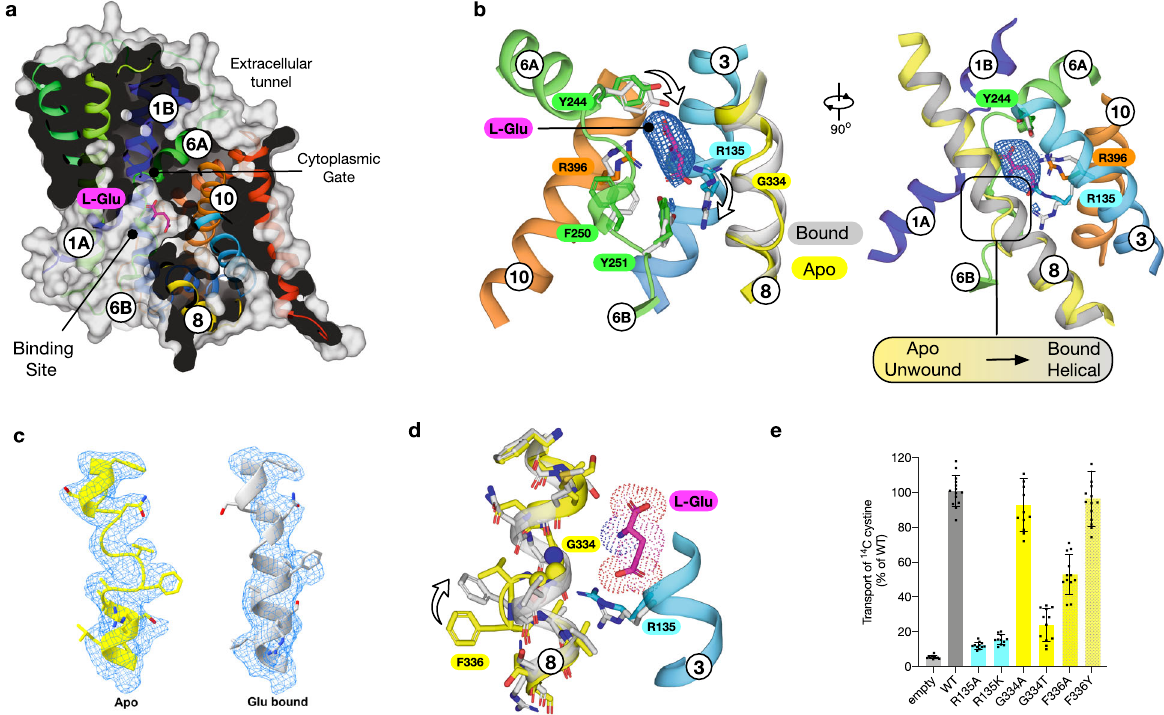
Fig. 3 L -glutamate bound structure of xCT. a Molecular surface representation of SLC7A11 showing the bound L-Glu ligand. b Zoomed in view of the ligand binding site with differences between TM8 in the apo (coloured) and bound (grey) states. The EM density for the ligand is shown, threshold 8 sigma. c Cryo-EM density for TM8 for the apo (yellow) and L -Glu bound (grey) structures. d Structural differences on TM8 between bound and unbound forms in relation to the re-positioning of Arg135 on TM3 and subsequent repositioning of Phe336. e Transport assays of cystine uptake for cells transfected with a plasmid containing wild type or variant forms of SLC7A11 or the empty plasmid as a negative control. n = 12 independent experiments, data are presented as mean values and error bars